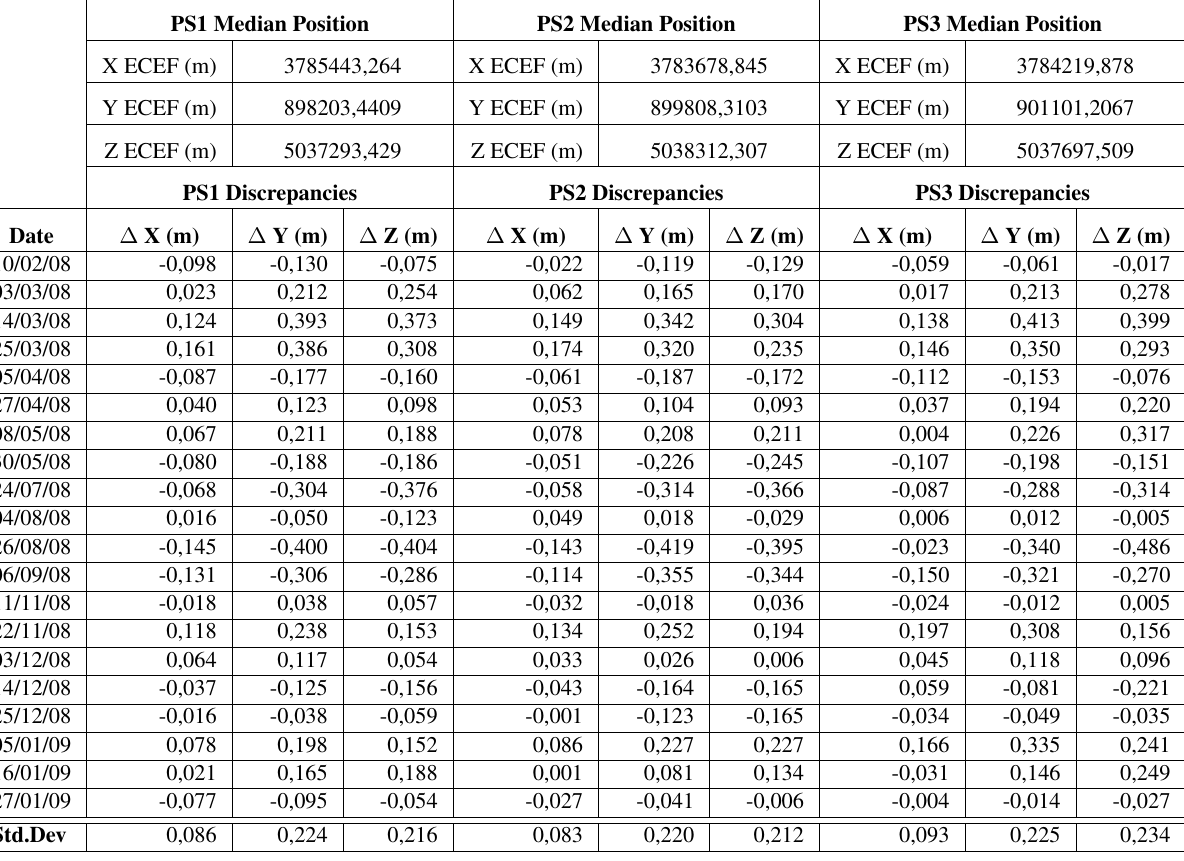
Table 2: PS’s estimated positions discrepancies